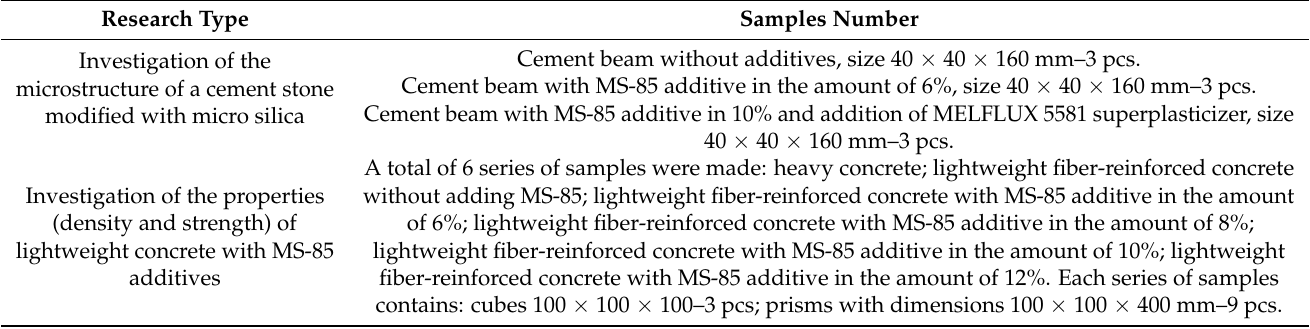
Table 10. Experimental research